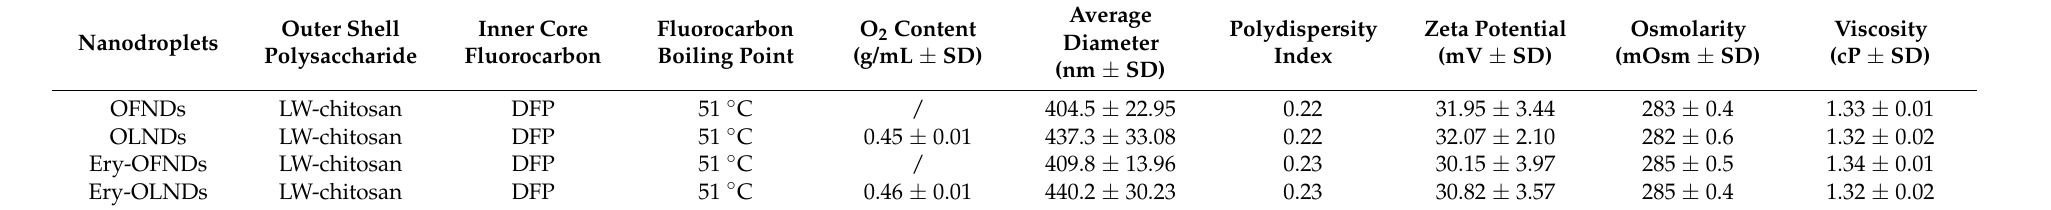
Table 1. Physico-chemical parameters of low weight chitosan-shelled oxygen-free or oxygen loaded nanodroplets added or not with